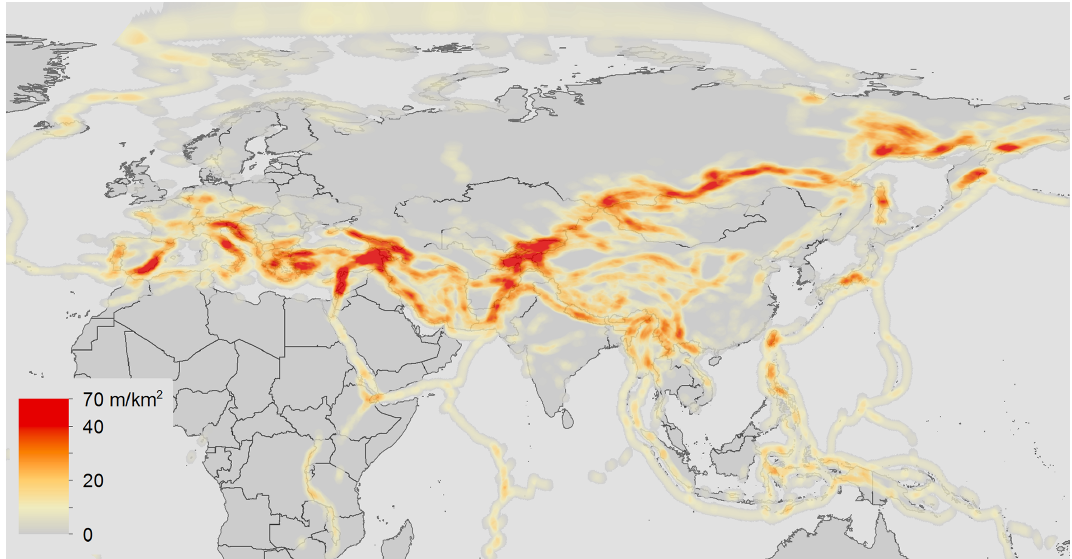
Figure 6. The density of active faults in AFEAD (in meters per square kilometer). Low-confidence faults (CONF of “D”) are omitted.